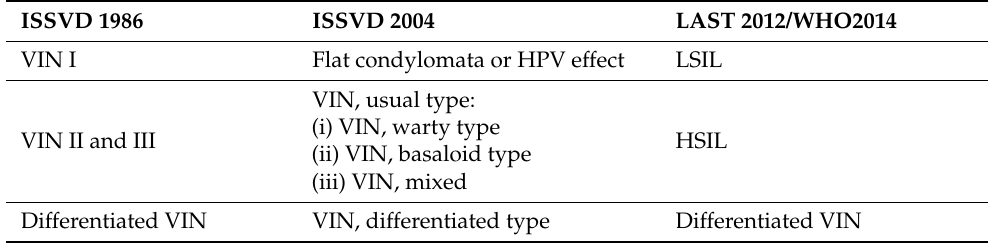
Table 1. Vulvar intraepithelial neoplasia (VIN) terminology changes [27–30]. ISSVD 1986 ISSVD 2004 LAST